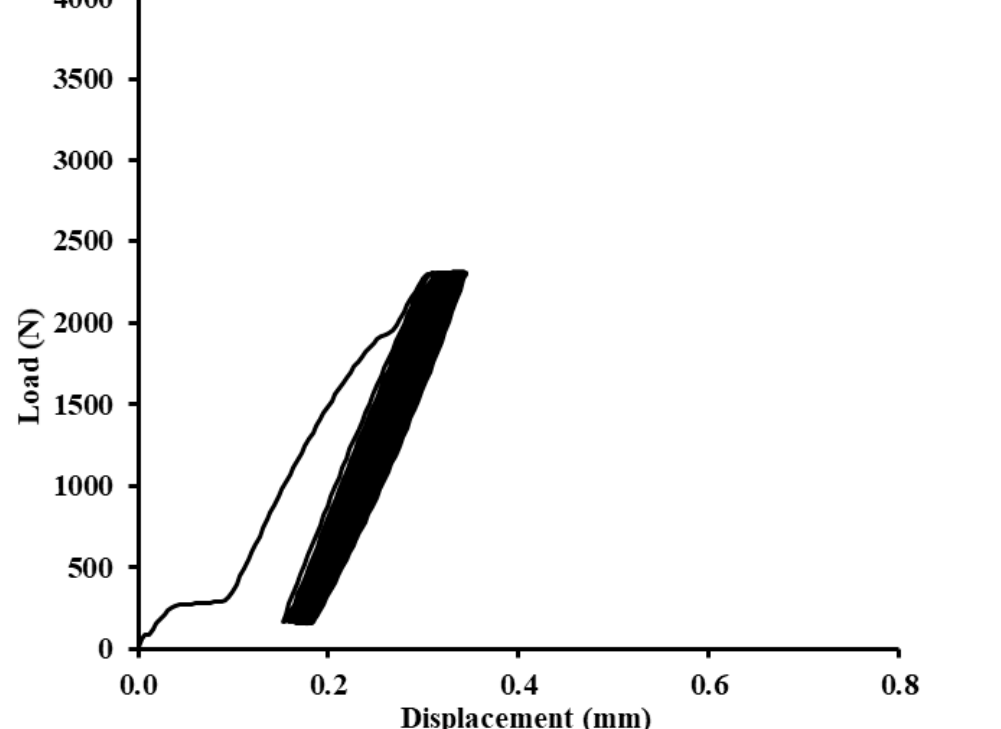
Polymers 2020 , 12 , x FOR PEER REVIEW Figure 15. Quasi-static graph of adhesive bond ABFE2 with loading 5–30% (165–989 N)—1000 cycles.